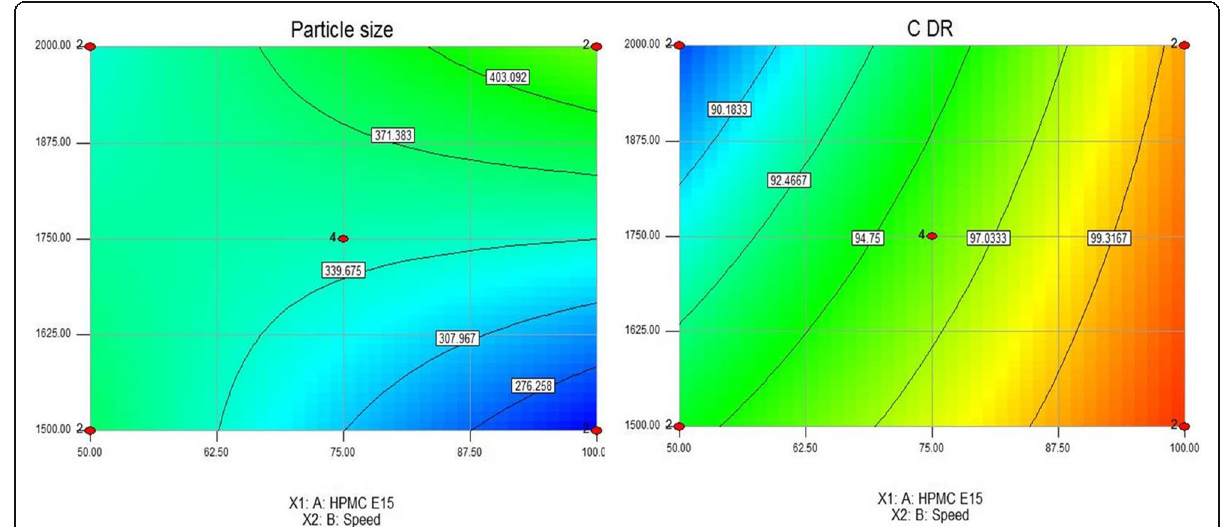
Fig. 5 Contour plot showing the effect of HPMC E15 and stirring speed on particle size and cumulative percentage drug release